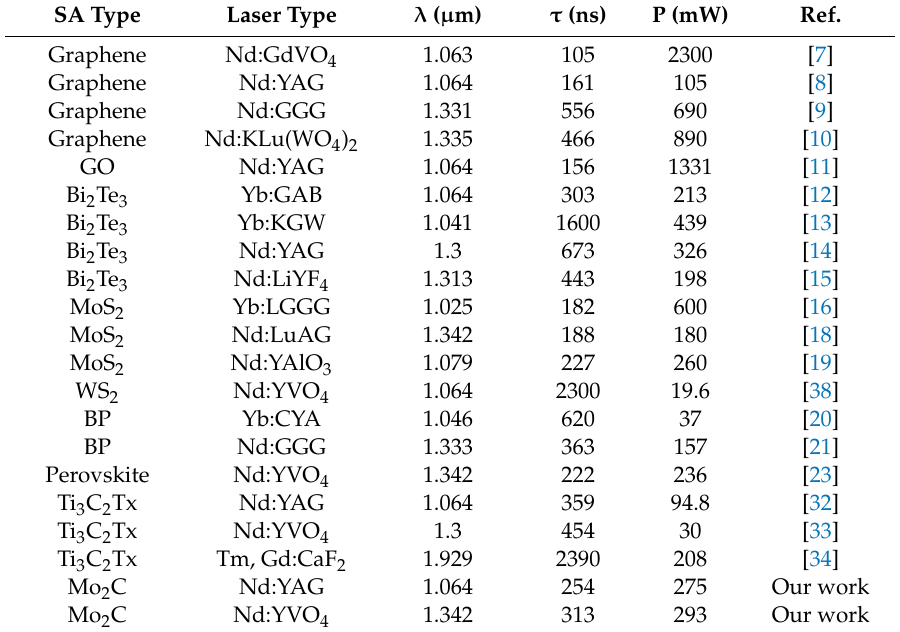
Table 1. Q-switched s lid-state lasers based on 2D